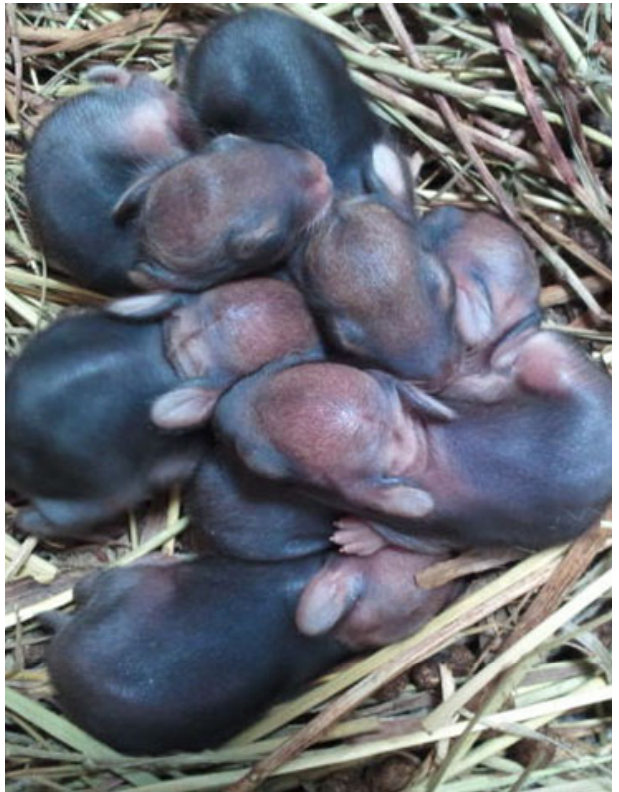
Figure 3. Newborn Kits. A litter of 1 ‐ day old kits, eyes shut and ears back. Source: Roger Williams Park Zoo.